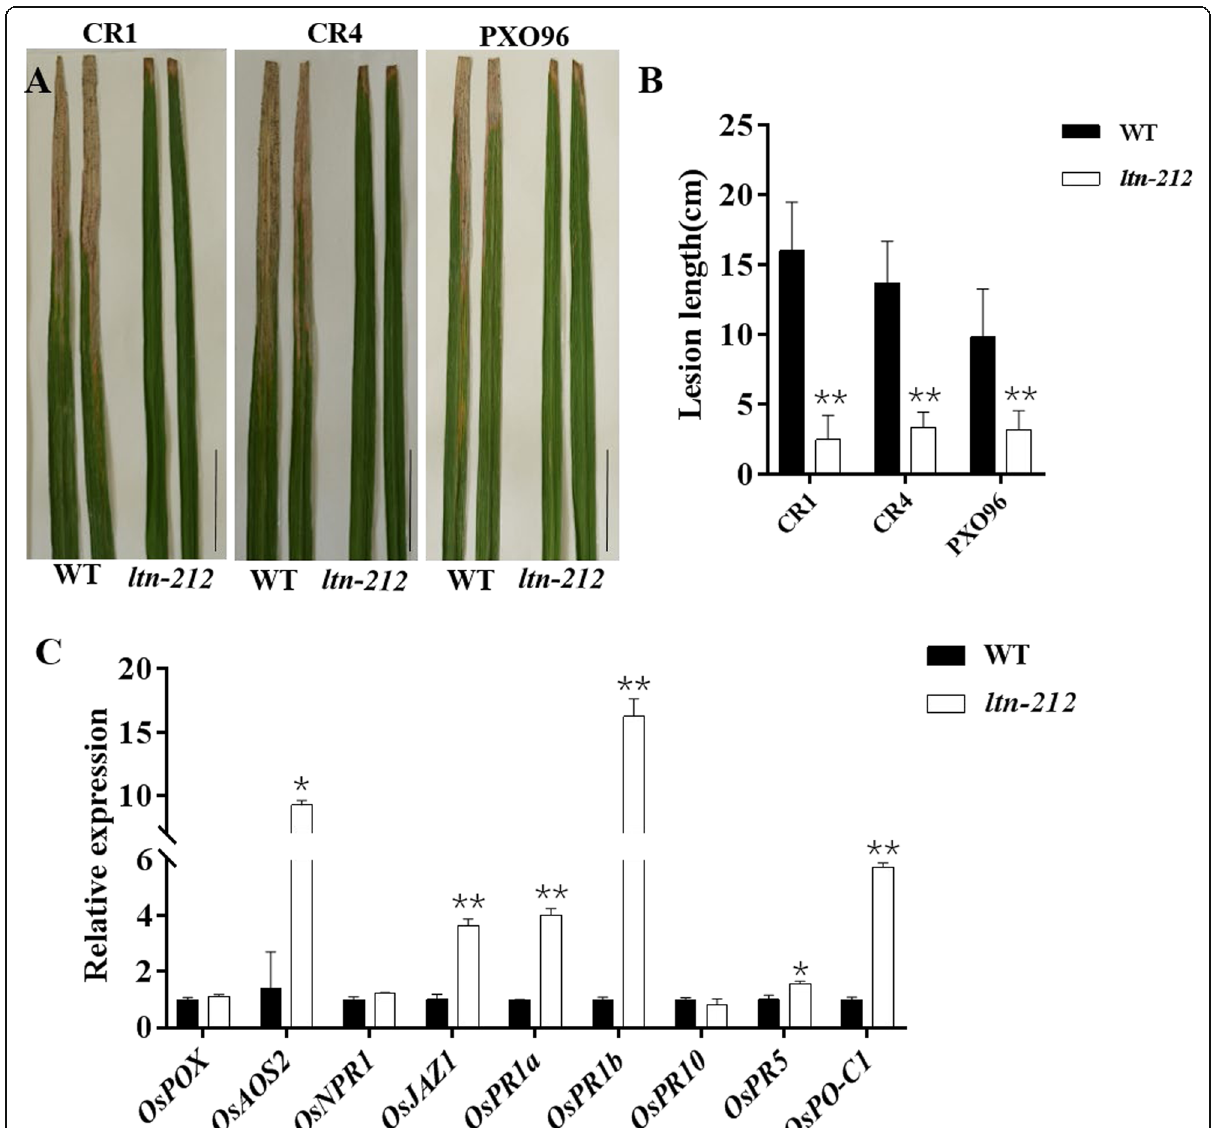
Fig. 3 Enhanced resistance in ltn-212 to Xoo . a Disease symptoms of WT and ltn-212 leaves after Xoo inoculation at 15 days (scale bar = 5 cm). b Lesion lengths measured at 15 days after inoculation with 3 different Xoo . Data are means ±SD of at least 15 leaves. c Expression analysis of defense-related genes. Data are means ± SD. ** indicates significance at P ≤ 0.01 and * indicates significance at P ≤ 0.05 (Student ’ s t